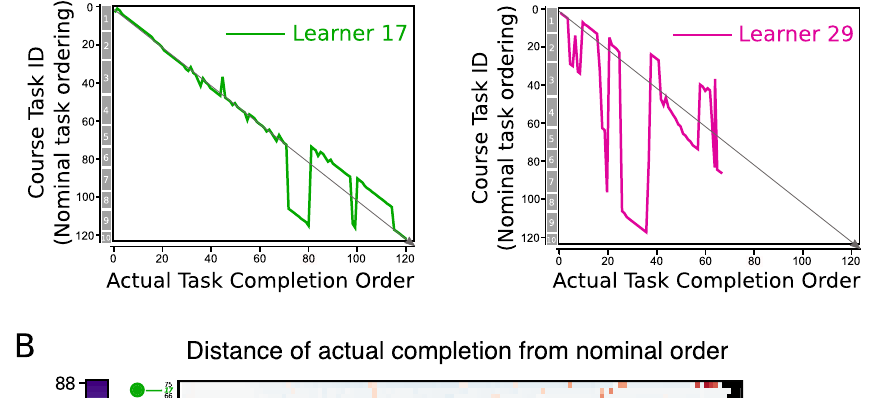
into two groups: those in the top 25% (Group 1) and bottom (Group 2) 25% of performers according to course